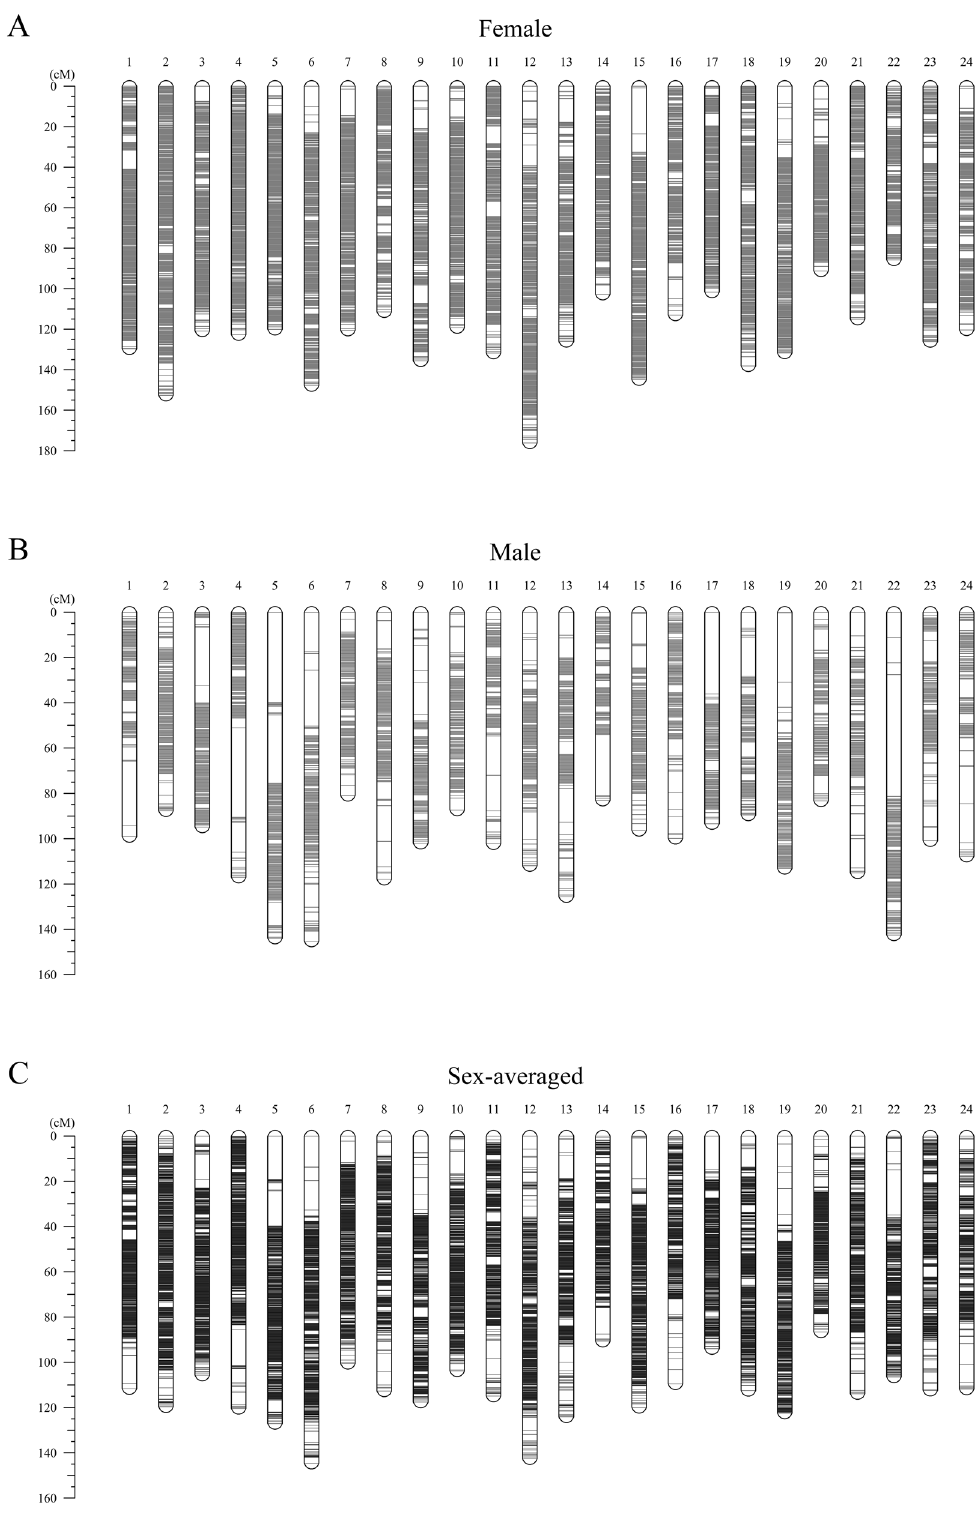
Figure 2. Genetic positions of markers for the 24 linkage groups in the ( a ) female, ( b ) male and ( c ) sex- averaged linkage maps. A black bar represents a SNP marker. The scale on the left indicates the genetic position in centiMorgan